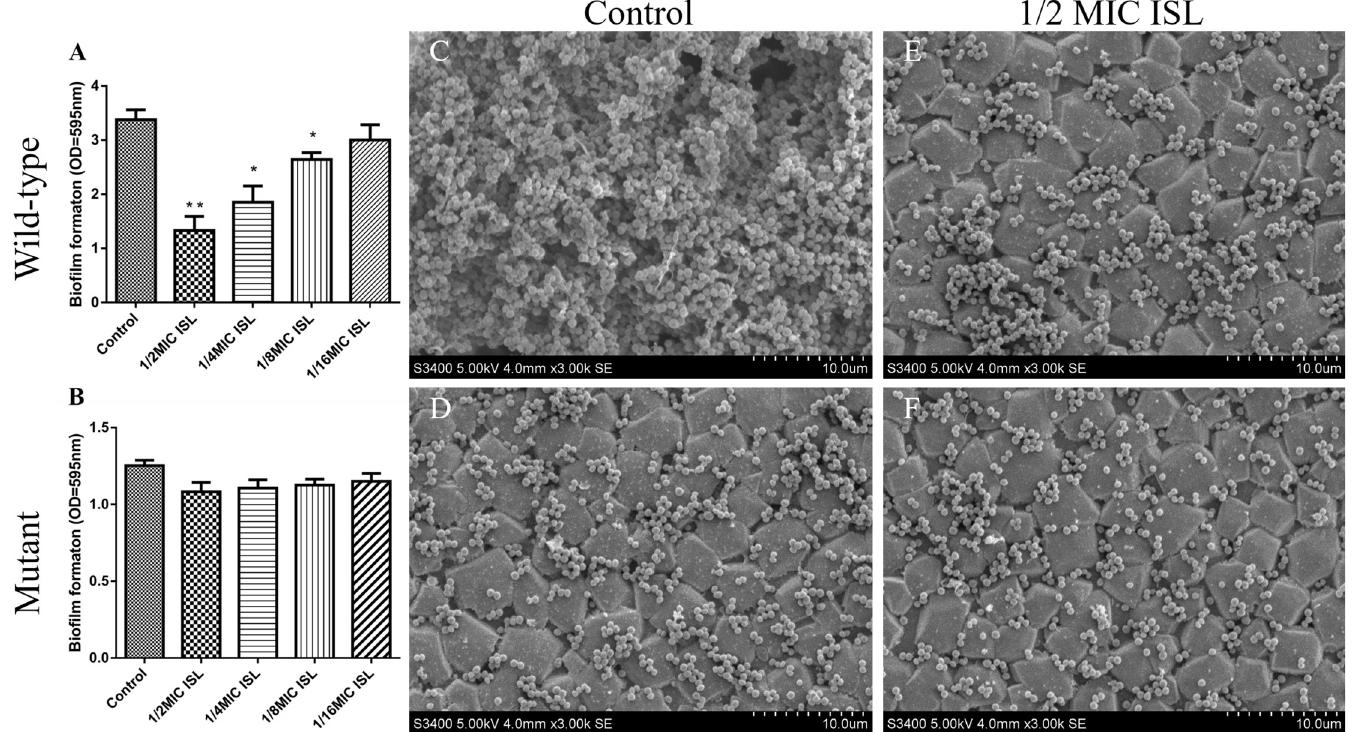
Fig 3. Determination of biofilm formation ability (A and B) and scanning electron microscope observation (C, D, E and F) of S . xylosus (wild or mutant). (A) Effect of sub-MICs of ISL on biofilm formation by wild-type S . xylosus strain. Data are expressed as means ± SDs. Controls refer to the absence of ISL. Significantly different means are indicated with asterisks ( � ) ( � p < 0.05, �� p < 0.01, and ��� p < 0.001) compared to the untreated control group. (B) Effect of sub-MICs of ISL on biofilm formation by mutant S . xylosus ATCC700404 strain. Data are expressed as means ± SDs. Controls refer to the absence of ISL. Means without asterisks ( � ) have no significant difference compared to the untreated control group. (C) Untreated wild-type strains; (D) Wild-type strains treated with 1/2 MIC of ISL (40 μ g/mL); (E) Untreated mutant strains; (F) Mutant strains treated with 1/2 MIC of ISL (20 μ g/mL).